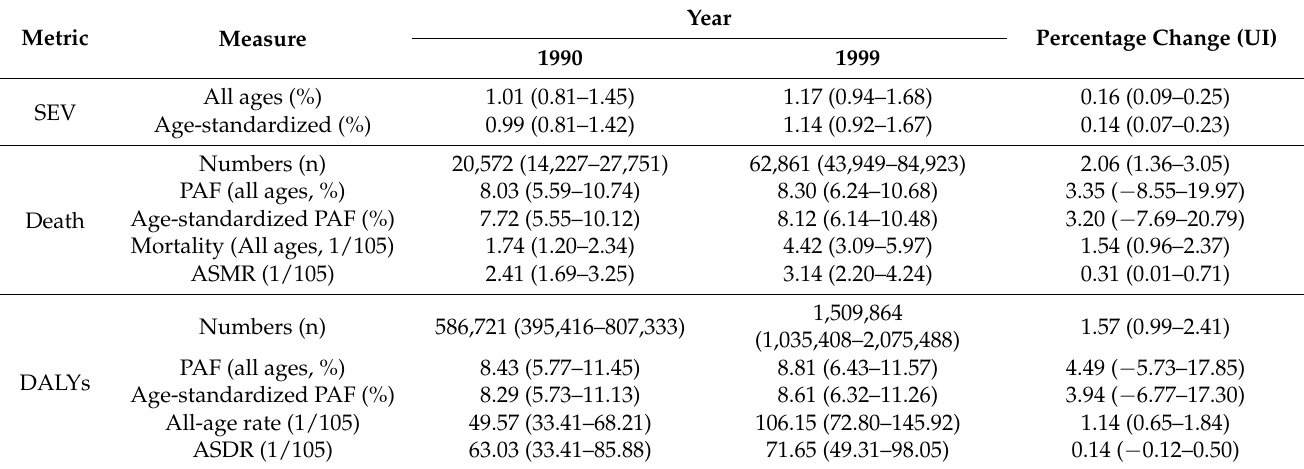
Table 1. The SEV and burden of lung cancer cases that can be attributed to occupational lung